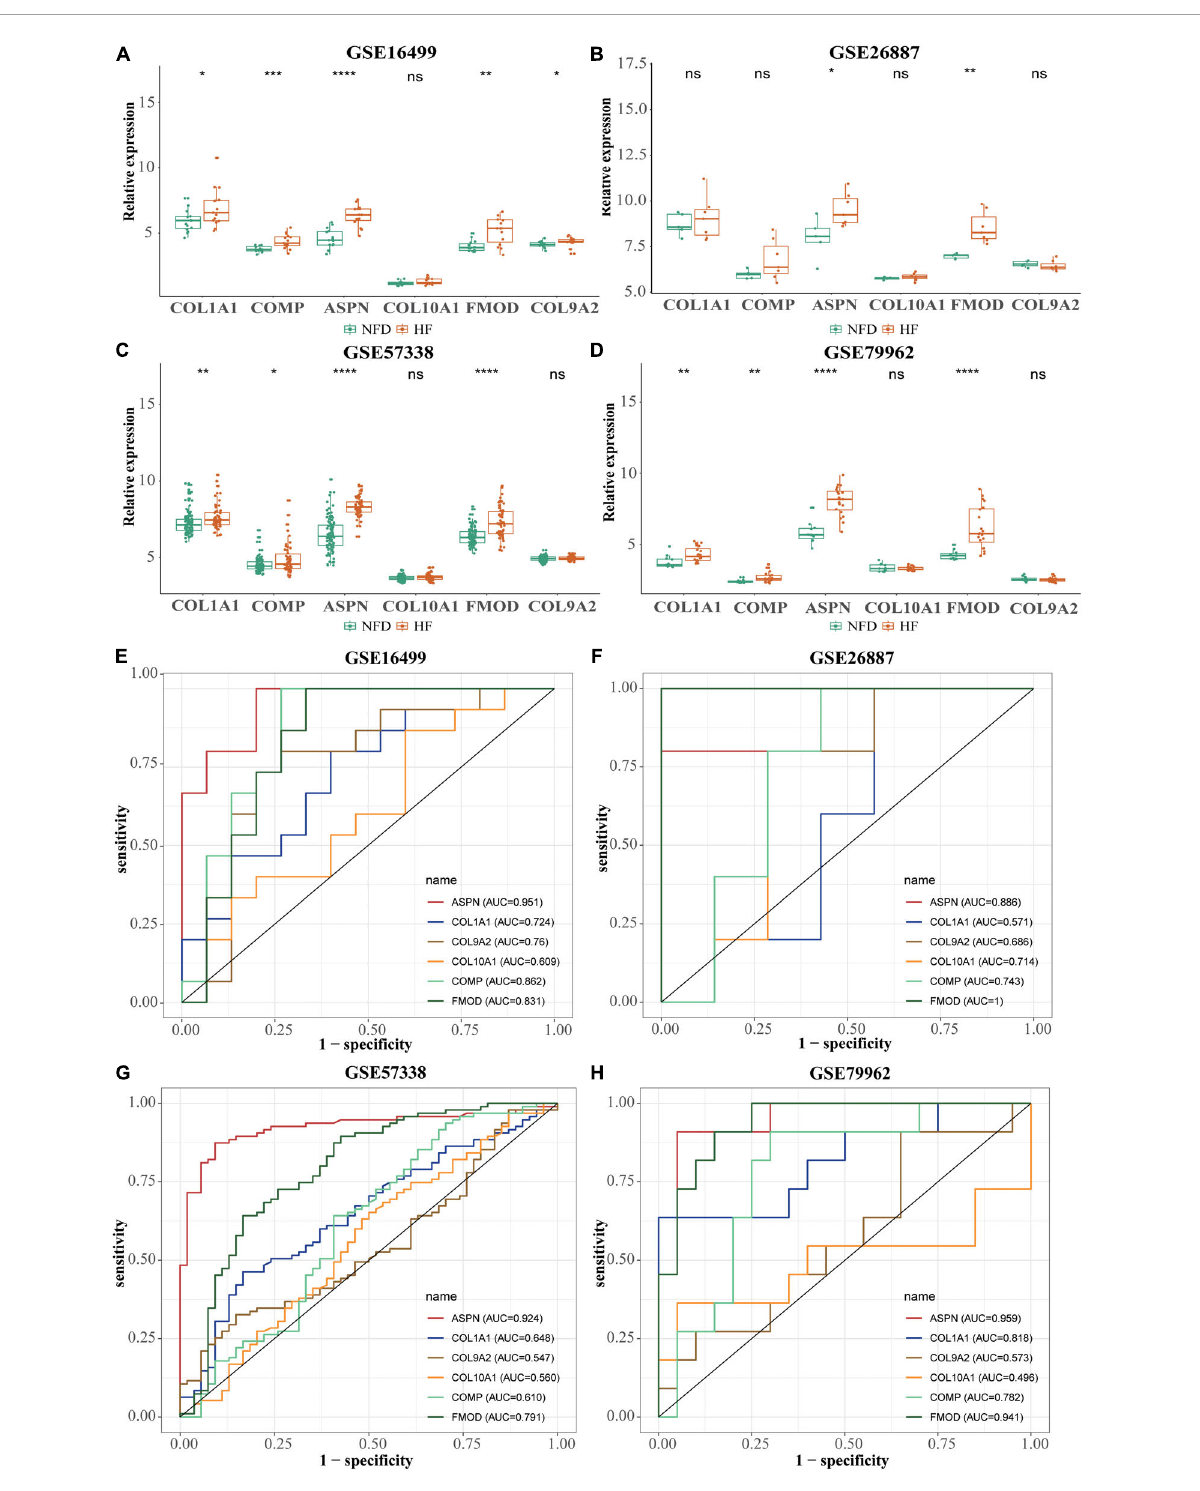
FIGURE8 Validation of the six hub genes using four normalized HF-related microarray datasets from the GEO database. (A–D) Relative expression of the six hub genes in GSE16499 (A) , GSE26887 (B) , GSE57338 (C) , and GSE79962 (D) , respectively. ns, not significant vs. the NFD group; * p < 0.05 vs. the NFD group; ** p < 0.01 vs. the NFD group; *** p < 0.001 vs. the NFD group; **** p < 0.0001 vs. the NFD group. (E–H) Diagnostic values of the six identified hub genes in GSE16499 (E) , GSE26887 (F) , GSE57338 (G) , and GSE79962 (H) , respectively, as determined by ROC curves. HF, heart failure; GEO, Gene Expression Omnibus; NFD, non-failing donor; ROC, receiver operating